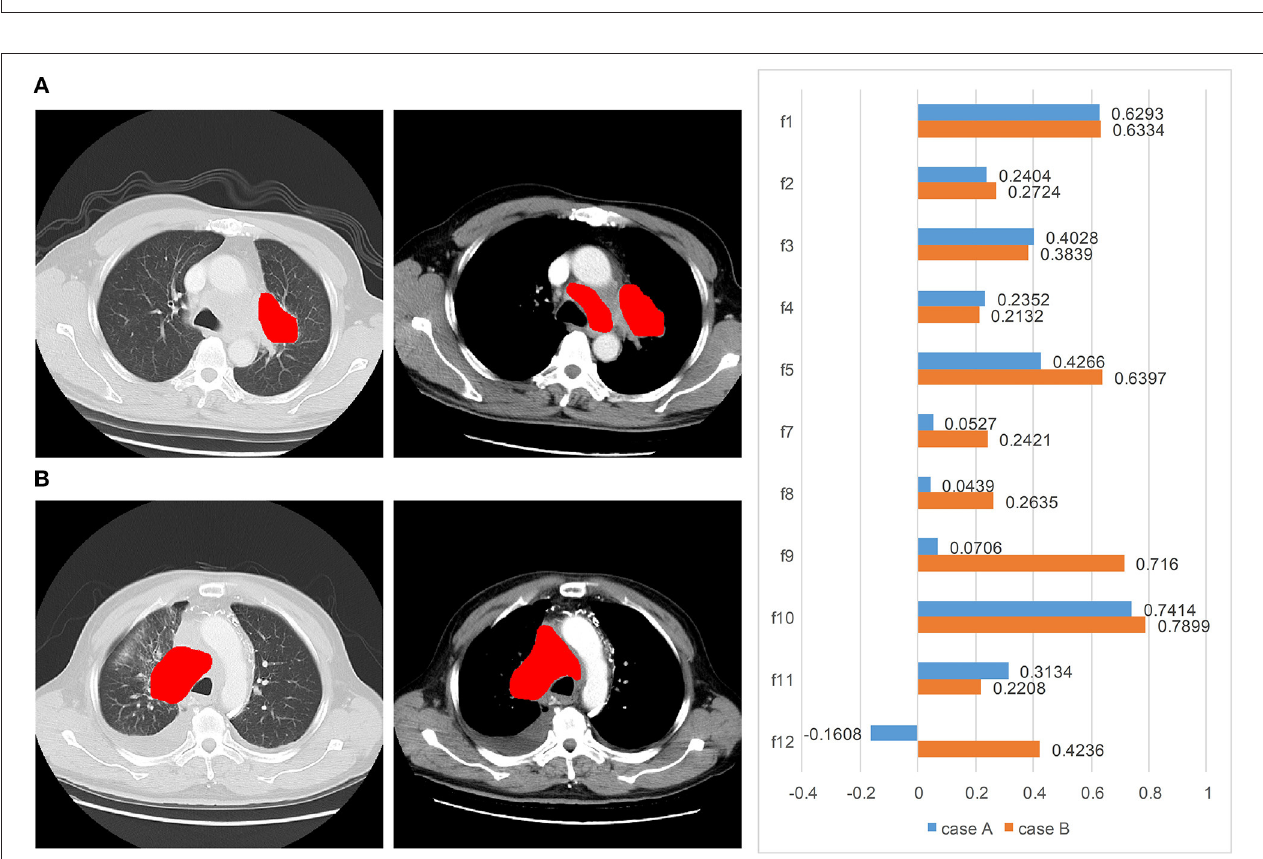
FIGURE 5 | Progression-free probability curves of the survival function generated by our model for three typical cases. (A) A patient with PFS less than 90 days (85 days); (B) a patient with PFS more than 90 days (156 days); and (C) a patient with PFS more than 1 year (431 days).